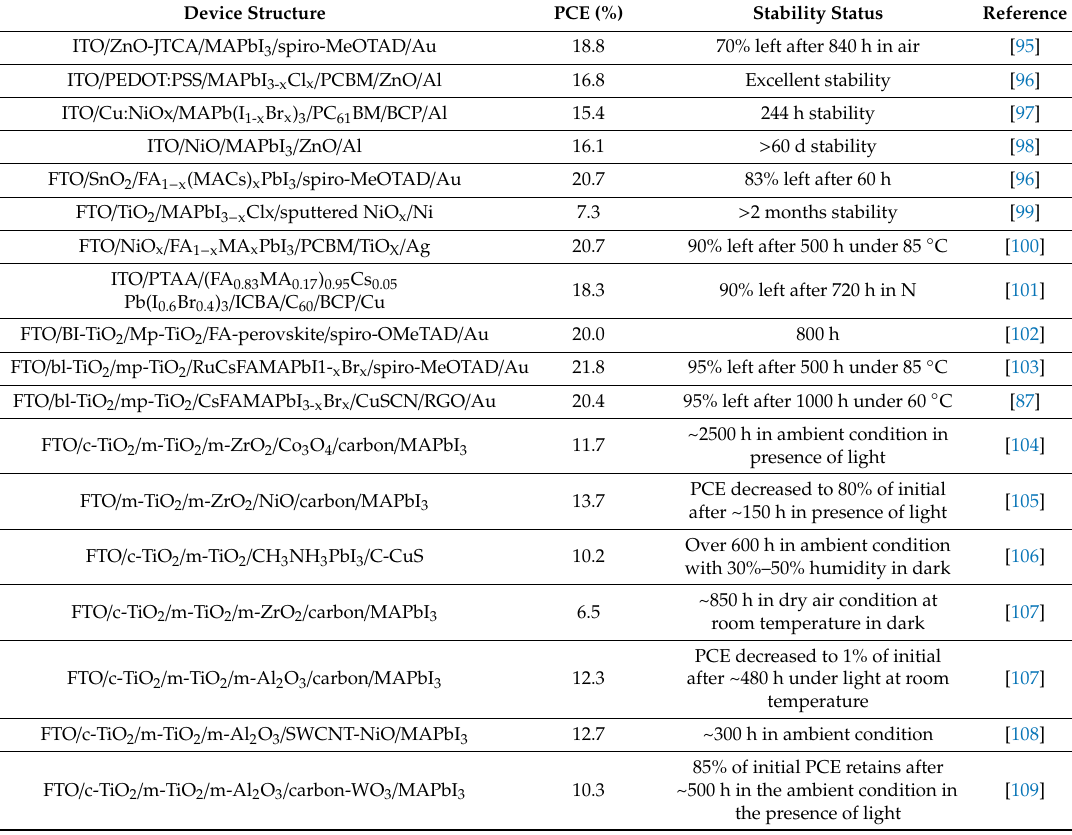
Table 3. Types of PSCs along with their e ffi ciency and